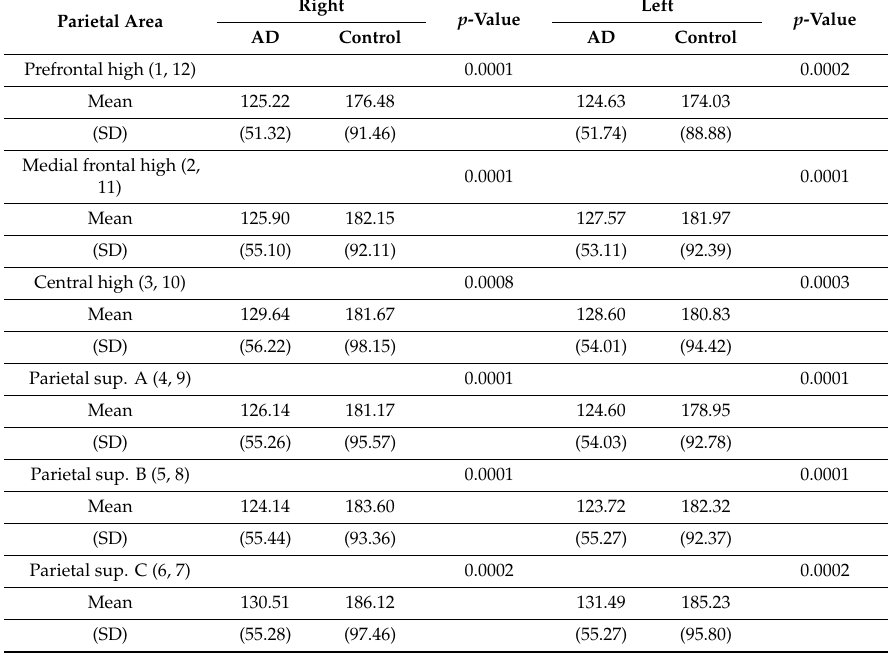
Table 1. Comparison count number parietal area of the brain for Alzheimer’s disease (AD) patients and control group (mean and SD).